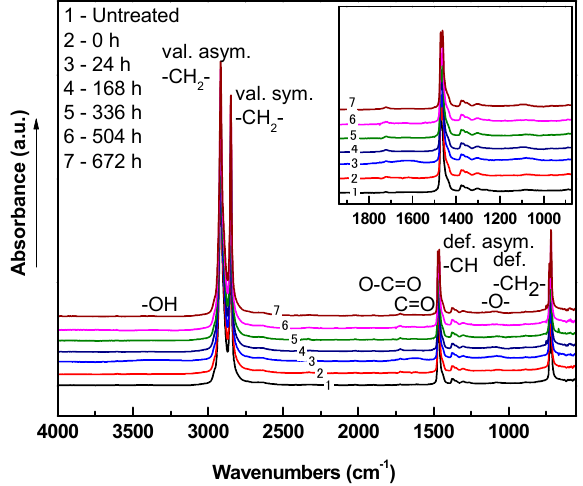
Figure 18. FTIR spectra of LDPE plasma treated for 120 s using argon and stored in air.